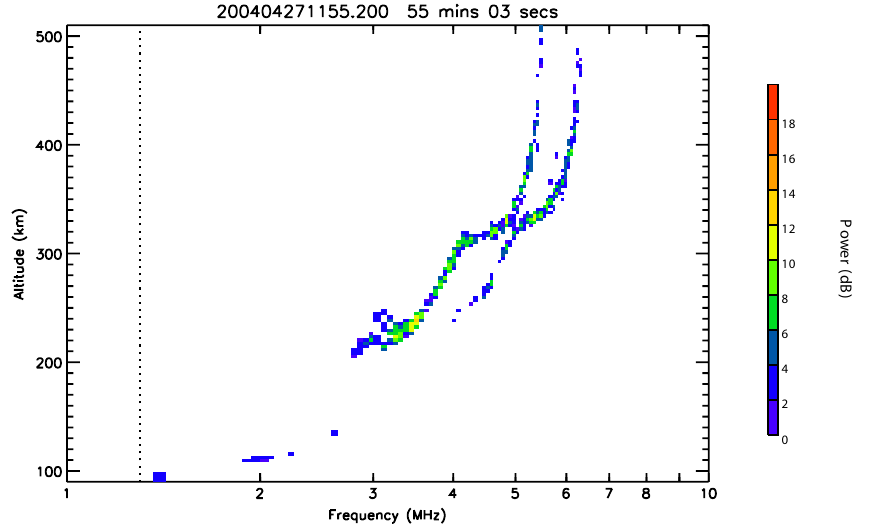
Fig. 6. Svalbard ionogram for 11:55 UT, 27 April 2004.